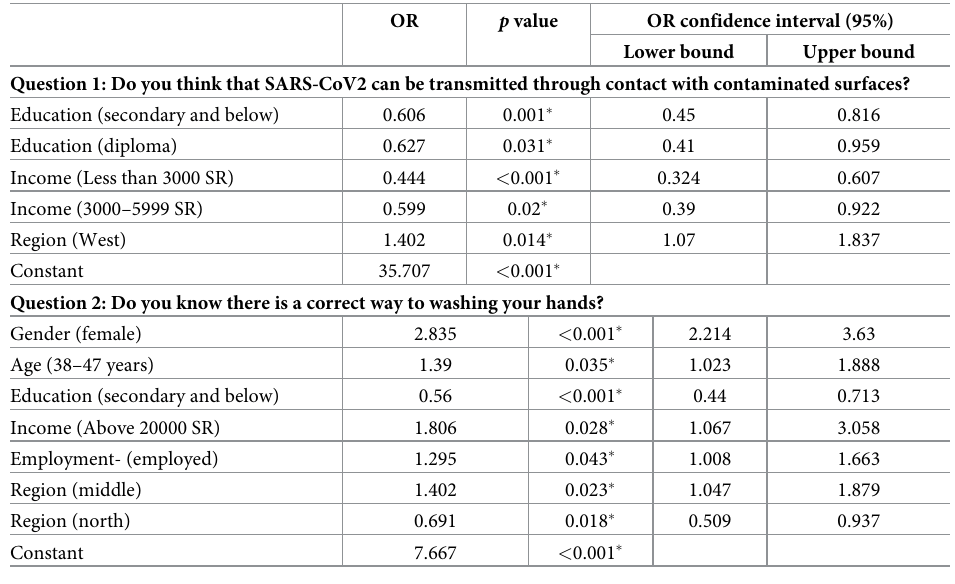
Constant 7.667 < 0.001 �